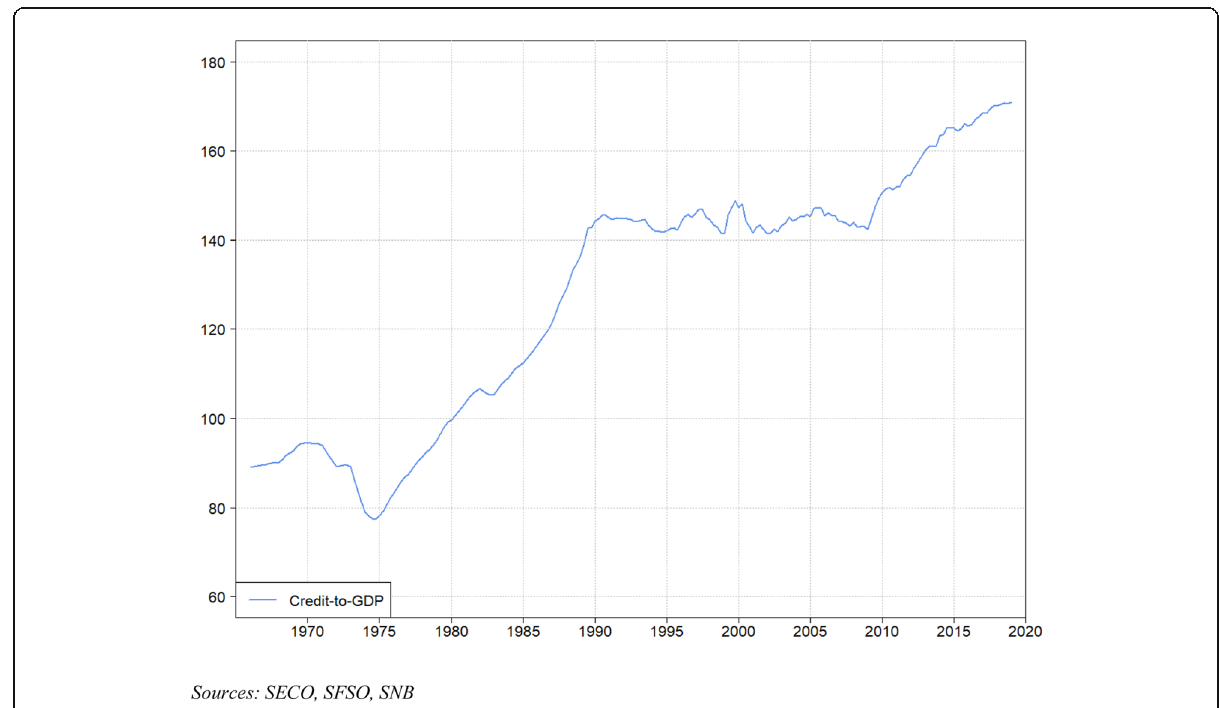
Fig. 1 Evolution of the credit-to-GDP ratio in